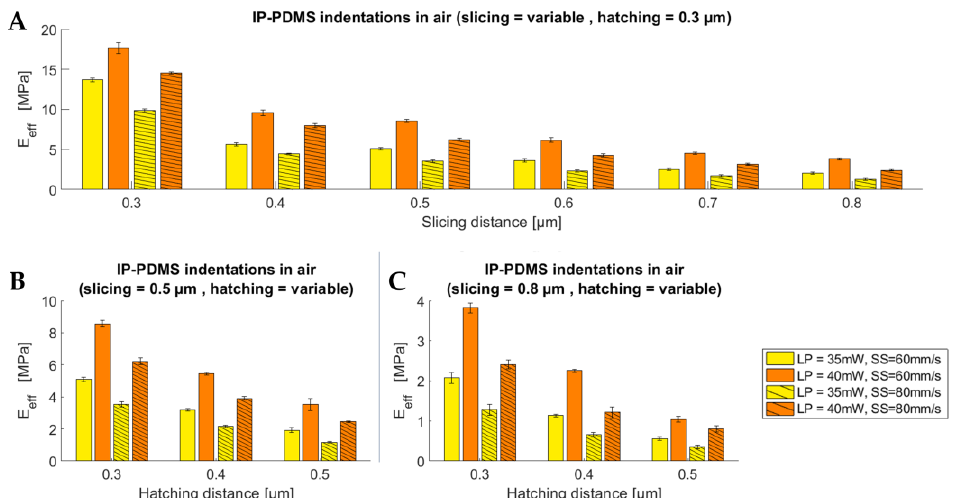
Figure 4. Indentation results showing the influence of slicing and hatching distance on the effective Young’s modulus of IP-PDMS. ( A ) Influence of the slicing distance on the effective Young’s modulus with a constant hatching distance of 0.3 µm. ( B ) Influence of the hatching distance on the effective Young’s modulus with a constant slicing distance of 0.5 µm. ( C ) Influence of the hatching distance on the effective Young’s modulus with a constant slicing distance of 0.8 µm.